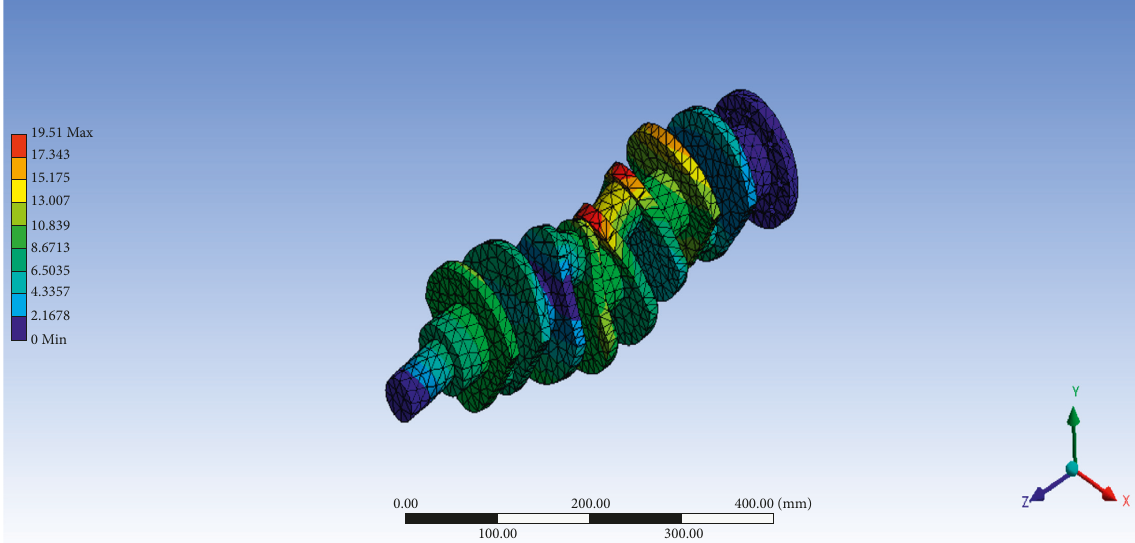
Figure 14: Deformation of carbon fiber composite crankshaft at the fourth mode of vibration.